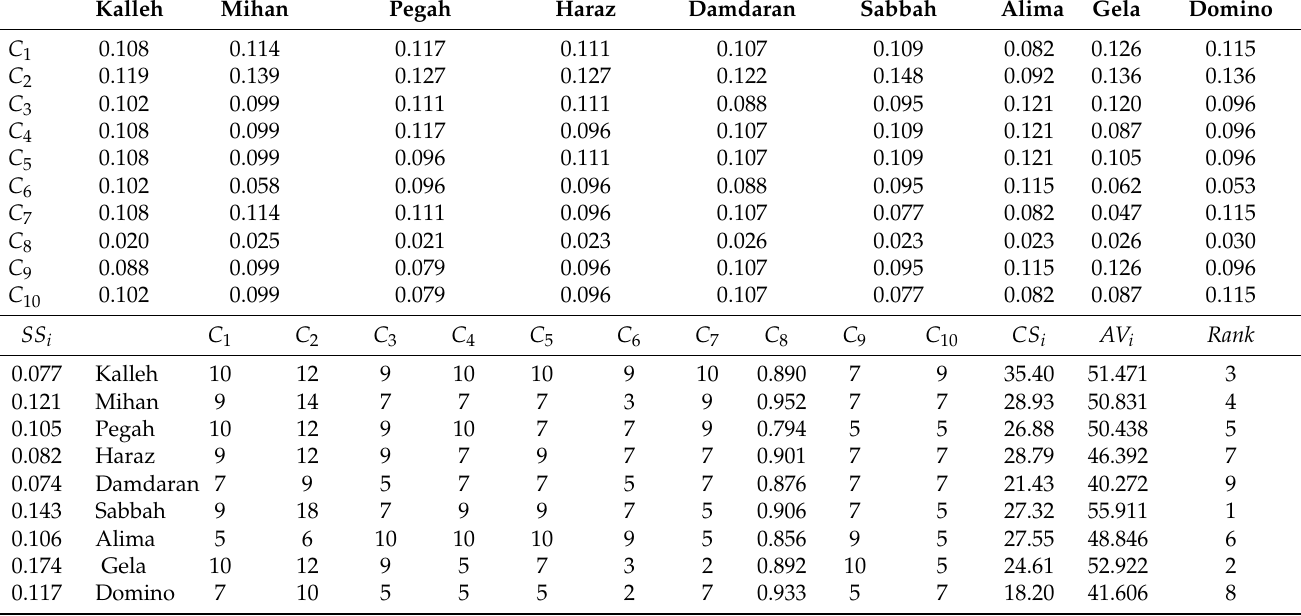
Table 15. The normalized transformed benefit matrix, entropy ( E j ), ( SS i ), and the final ranking of the cheese suppliers of the first